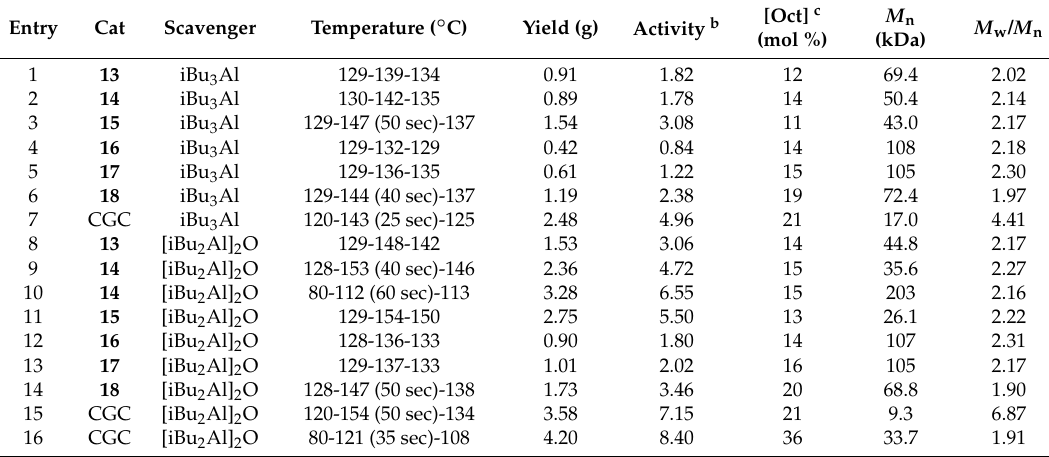
Table 1. Ethylene/1-octene copolymerization results a .